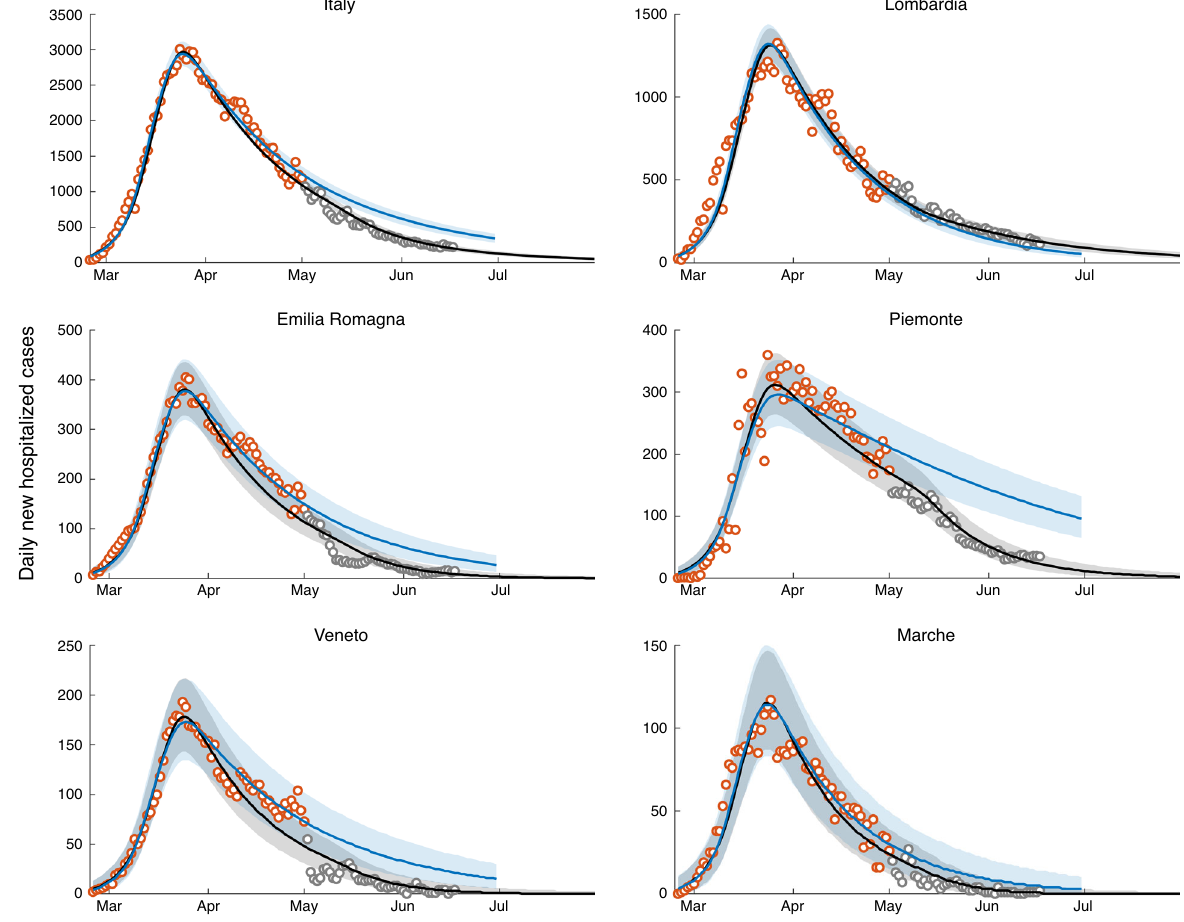
Fig. 5 Ex-post assessment. Daily numbers of newly hospitalized cases for Italy and its hardest hit regions. Clockwise from top: Italy, Lombardia, Piemonte, Marche, Veneto, and Emilia Romagna. The remaining regions are shown in Supplementary Fig. 8. Red empty circles represent data available for the projection of the scenarios presented in Fig. 2, gray empty circles show the newly available data. Blue colors (solid line: median results, shaded area: 95% con fi dence intervals) report here, for the sake of comparison, the baseline scenario already presented in Fig. 2. Black colors show the results of the updated parameter estimation that exploits all data available up to June 17. Table 2 Ex-post assessment of transmission rate.